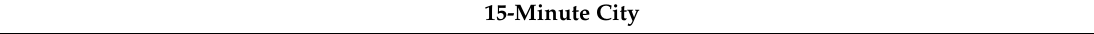
Table 1. The 15-Minute City concept.